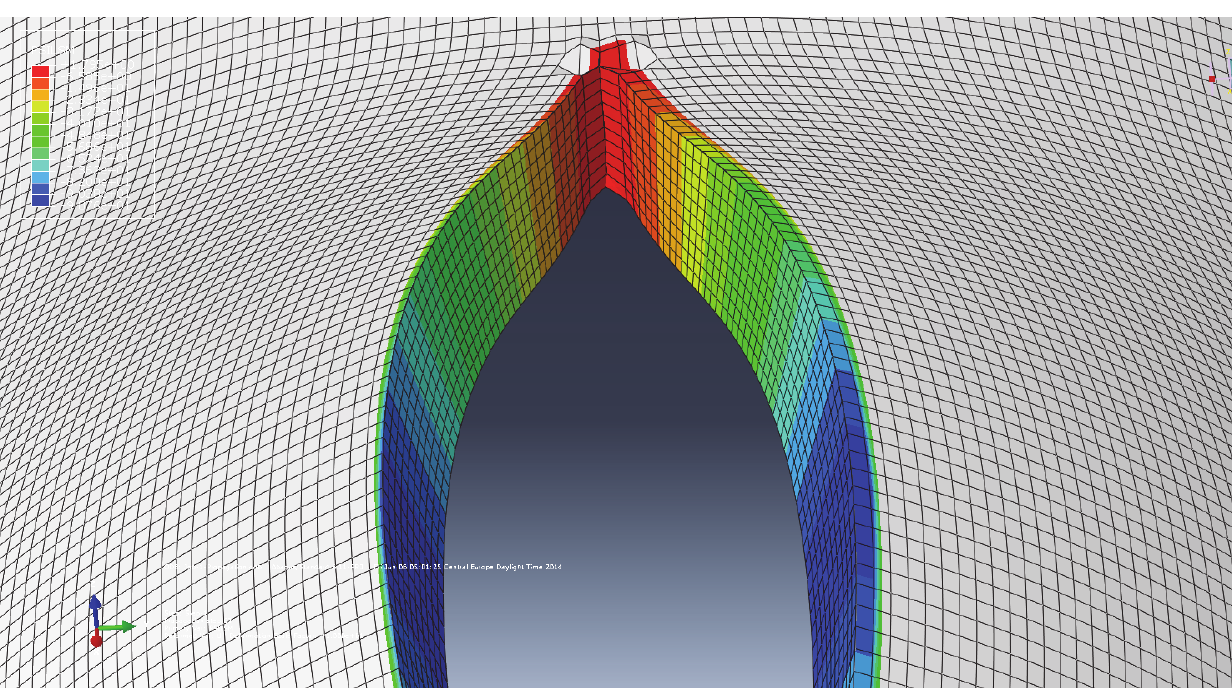
Figure 9: Step 64 when “inner” and “outer” crack going to be equal (crack length is 200 mm) and stresses around the crack.